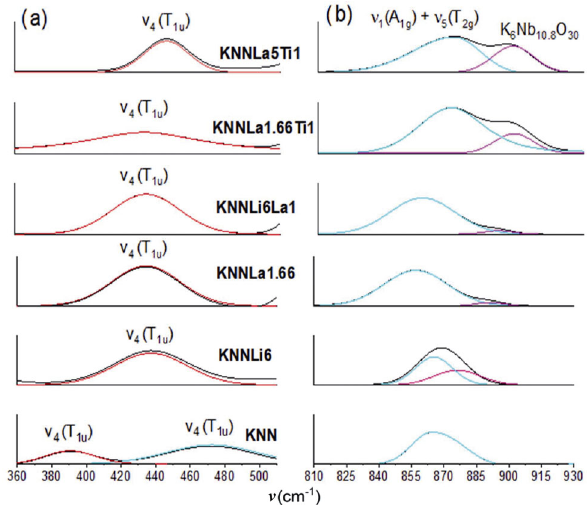
Fig. 4 Deconvoluted detail of (a) modes ν 4 at frequencies ranging from 360 to 510 cm –1 and (b) ν 1 +ν 5 and K 6 Nb 10.8 O 30 at the frequencies ranging from 810 to 930 cm –1 .